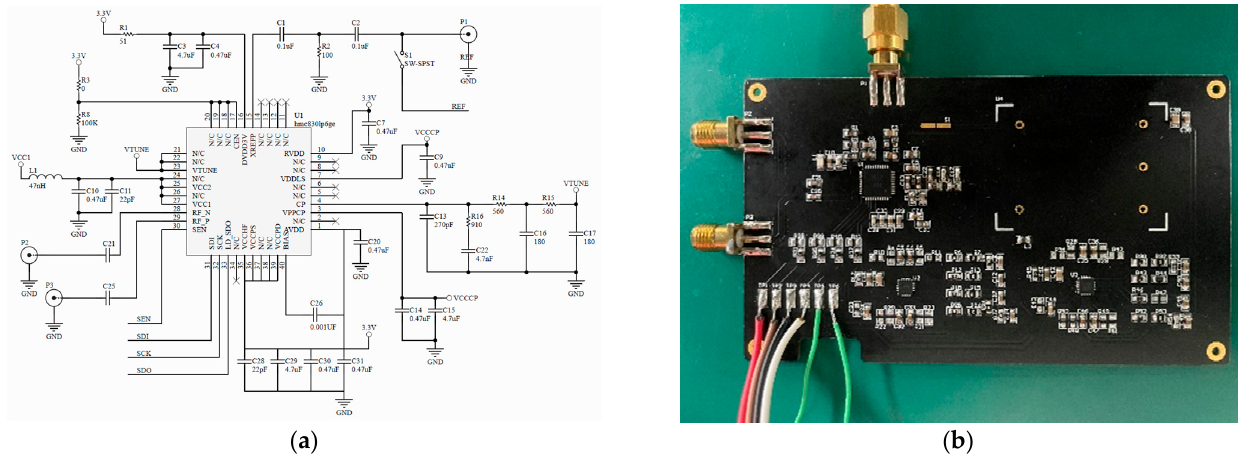
Figure 4. Circuit design: ( a ) circuit design of the PLL section and ( b ) the circuit